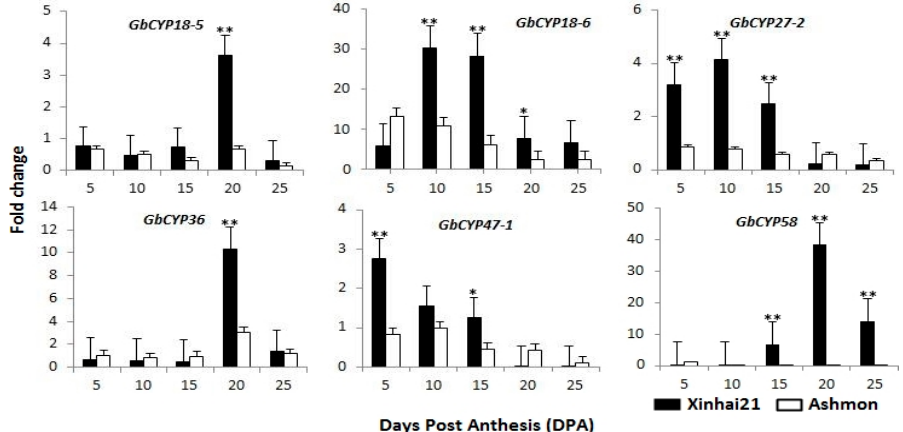
Figure 9. Expression profiles of six GbCYPs between Xinhai21 and Ashmon based on qRT ‐ PCR. GbUBQ7 was used as an internal reference to normalise the expression data. Error bars were calculated from the difference in the expression patterns of three biological replicates. The asterisks and double asterisks indicate correlations at the 0.05 and 0.01 significance levels, respectively (t ‐ test, * p < 0.05, ** p < 0.01).